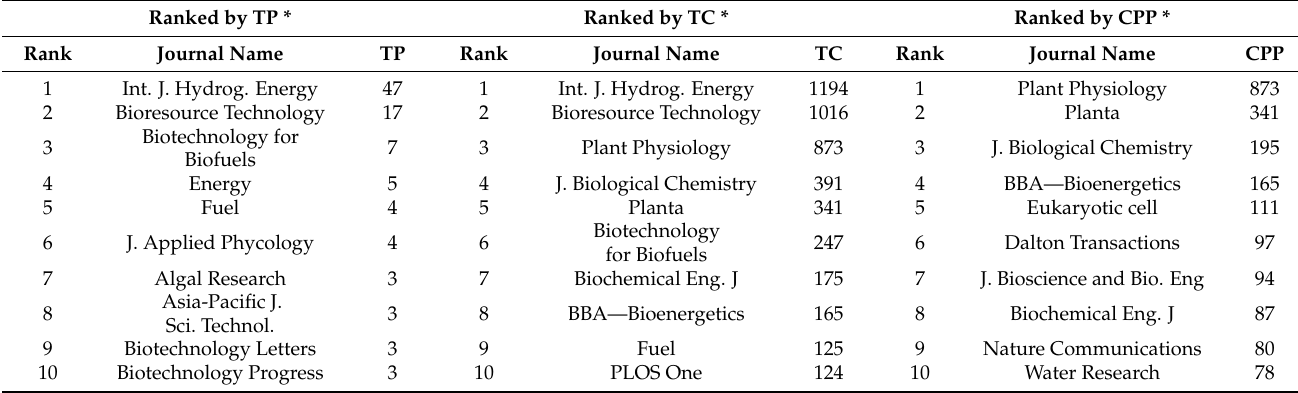
Table 2. Top Journals ranked by TC, TP, and